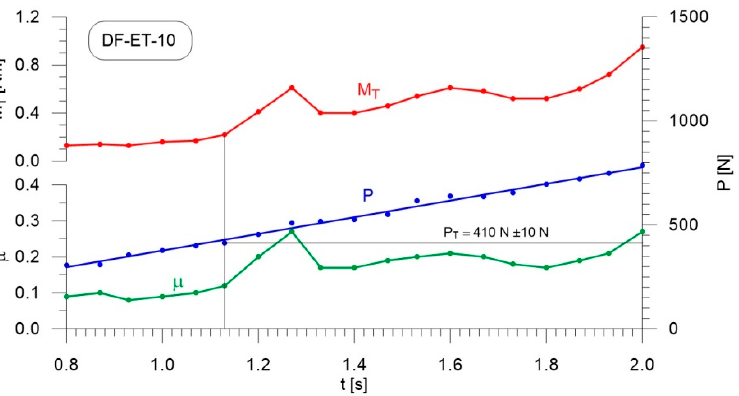
Figure 10. Courses of the load, P, the friction torque, M T , and the friction coefficient, µ, for diesel– ethanol blend with a 12% ethanol volume fraction.